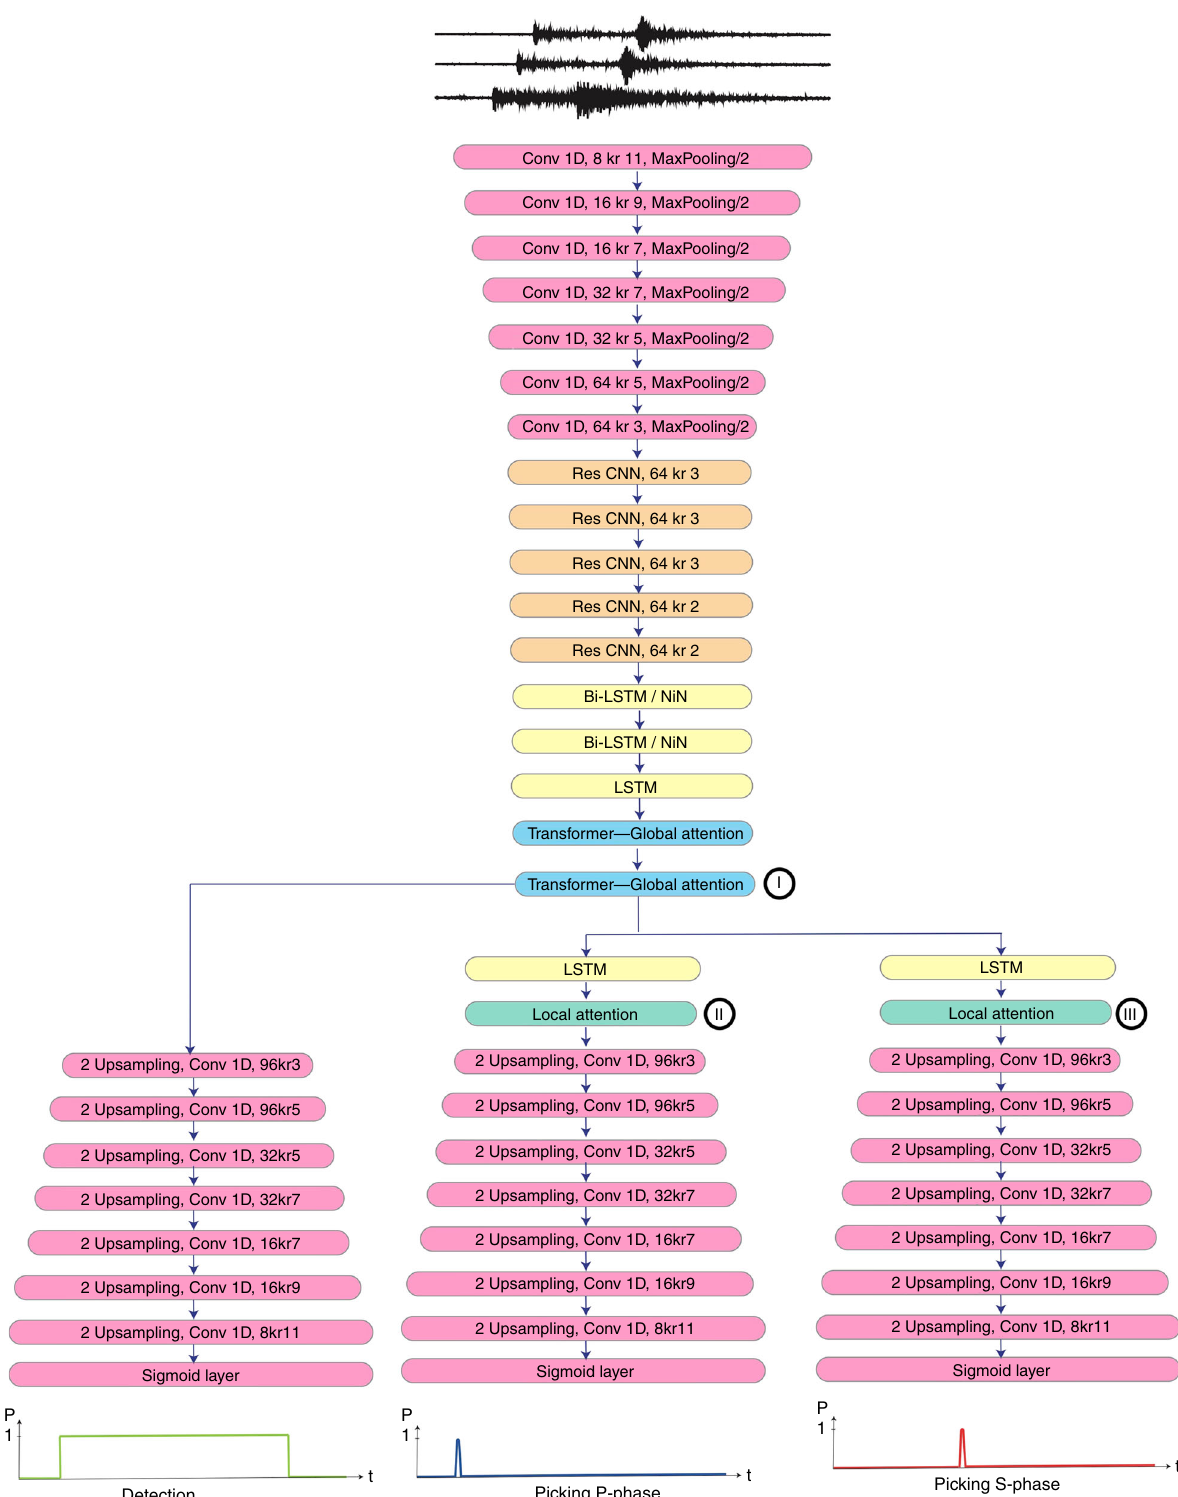
Fig. 1 Network architecture. Our network architecture. Full details of each block are provided in the method section. The convolutional layers read as (number of kernels) kr (kernel and higher F-score during our hyperparameter selection proce- dure and is used for the fi nal model. In this form, probabilities of P and S are set to 1 at the fi rst arriving P and S wave and linearly decrease to 0 within 20 samples before and 20 samples after each phase arrival.